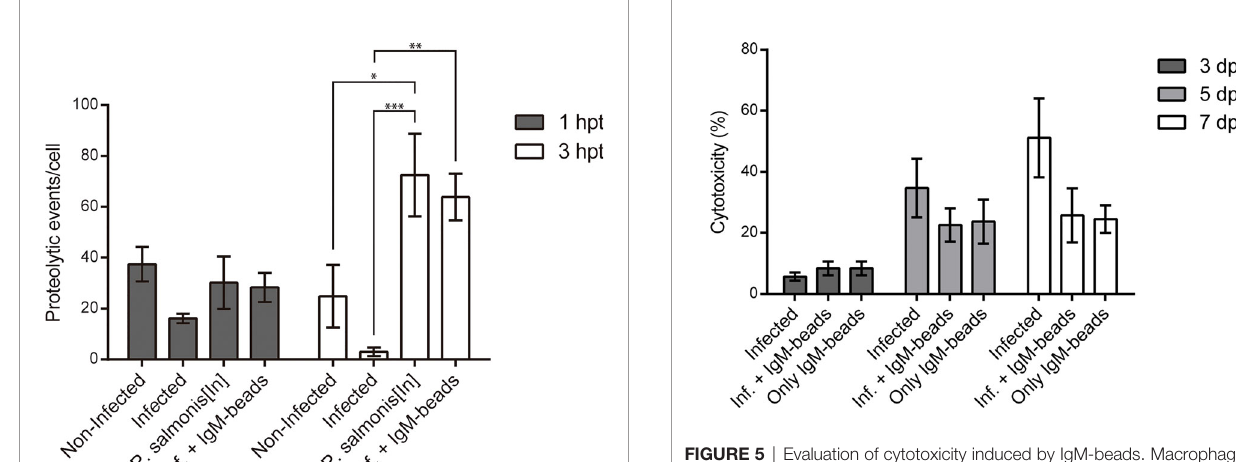
FIGURE 5 | Evaluation of cytotoxicity induced by IgM-beads. Macrophage- enriched cell cultures were infected with P. salmonis at MOI of 10 bacteria/ cell and treated with IgM-beads. The cytotoxicity was evaluated at 3, 5, and 7 dpi by the detection LDH release into the extracellular medium. The statistic test was performed using ANOVA with a Tukey multiple comparison test, the analysis was performed individually for each evaluated